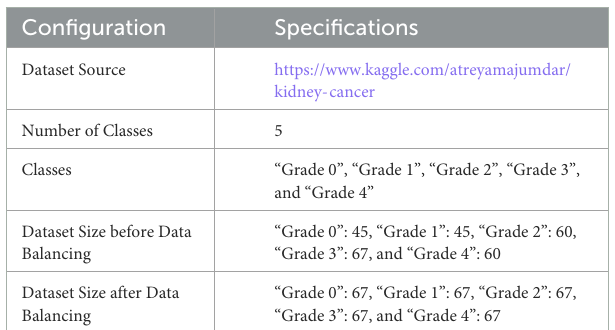
TABLE 12 Five-classes specific experiments